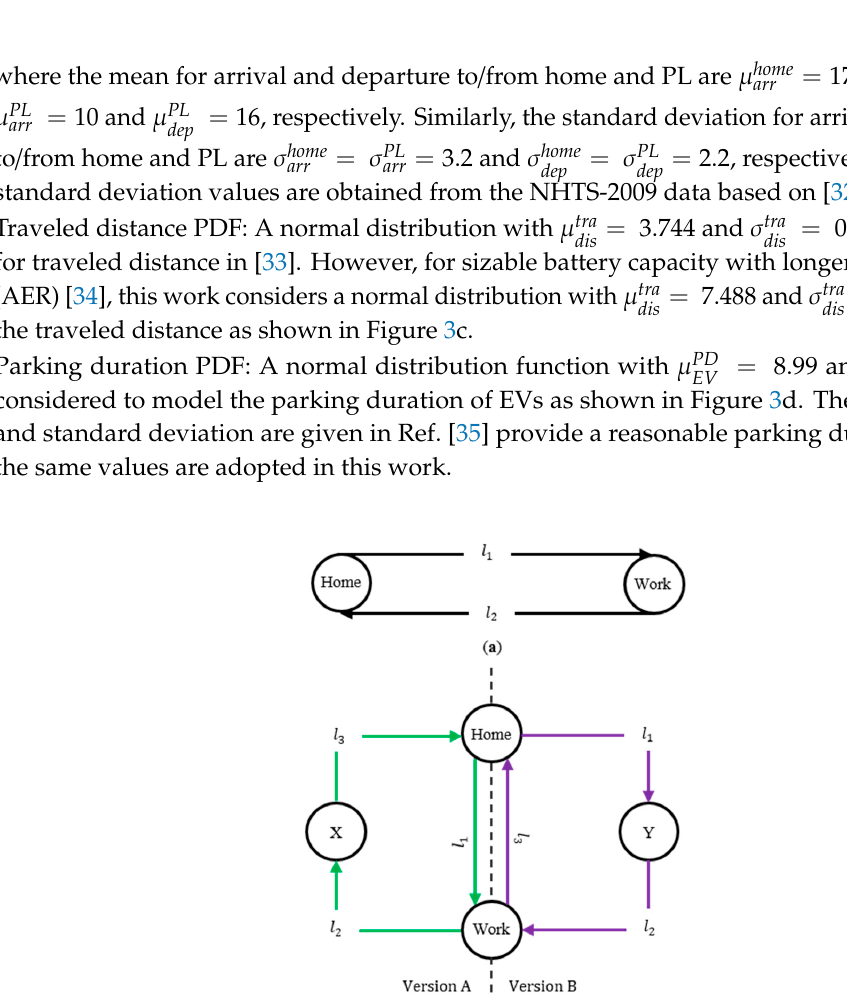
Figure 2. Two different types of EV owner’s daily trips: ( a ) Routine trip between home and workplace;